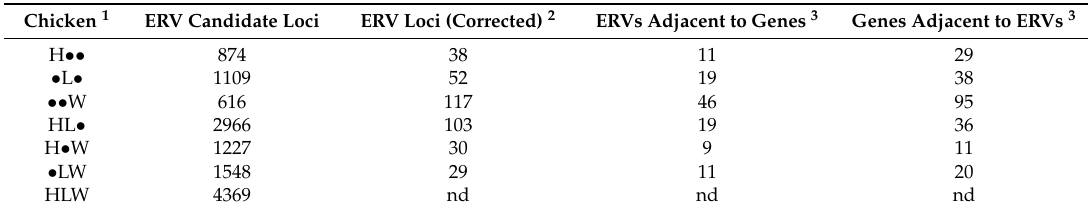
Table 2. Candidate ERV loci.